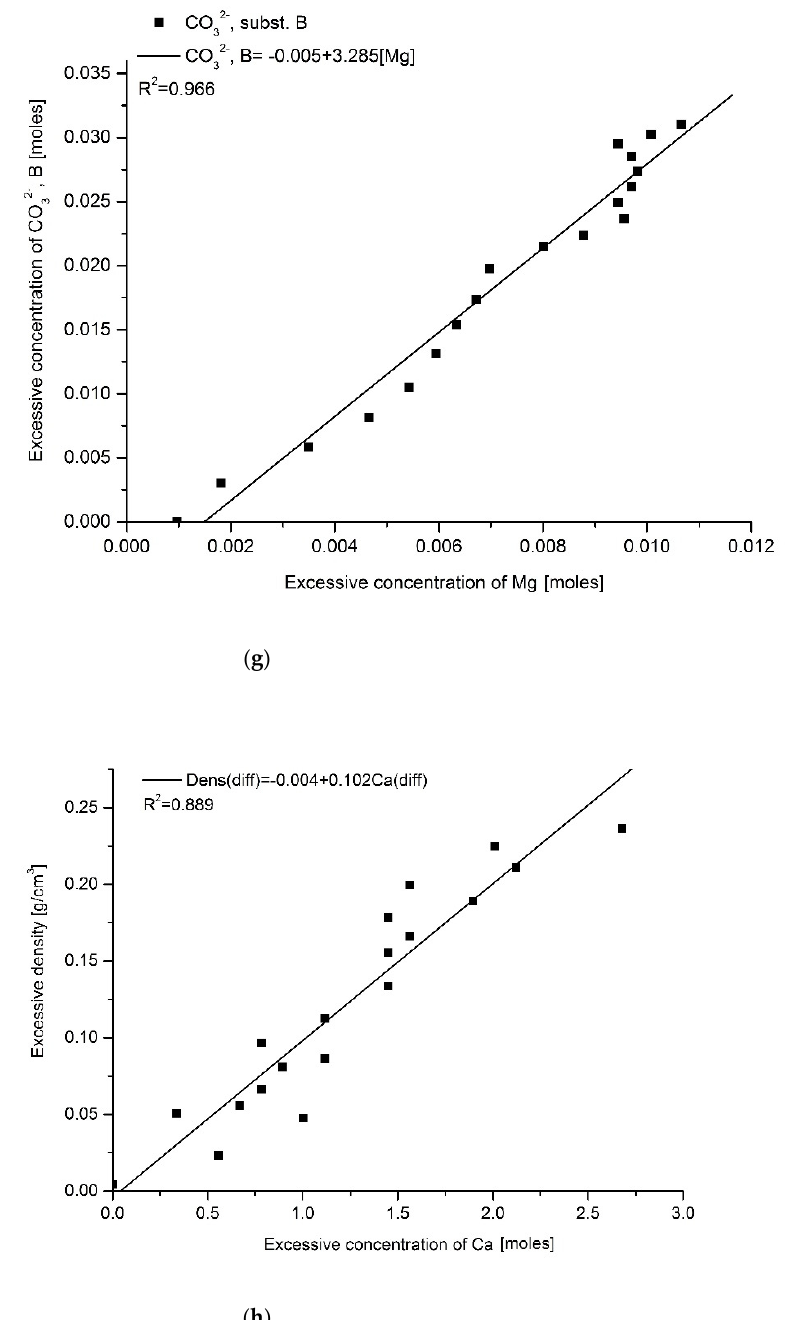
Figure 7. Correlations existing between the excessive amounts of some elements and other param- eters: ( a ) CO 32 − (B)—Na + K; ( b ) PO 43 − —Na + K; ( c ) CO 32 − (B)—PO 43 − ; all three relationships concerning Equation (3); ( d ) Cl + F—Mg; ( e ) Cl + F—Ca; (f) Ca—Mg; all three concerning Equation (4); ( g ) CO 32 − (B)—Mg—concerning junction between Equations (3) and (4); ( h ) Ca-density.